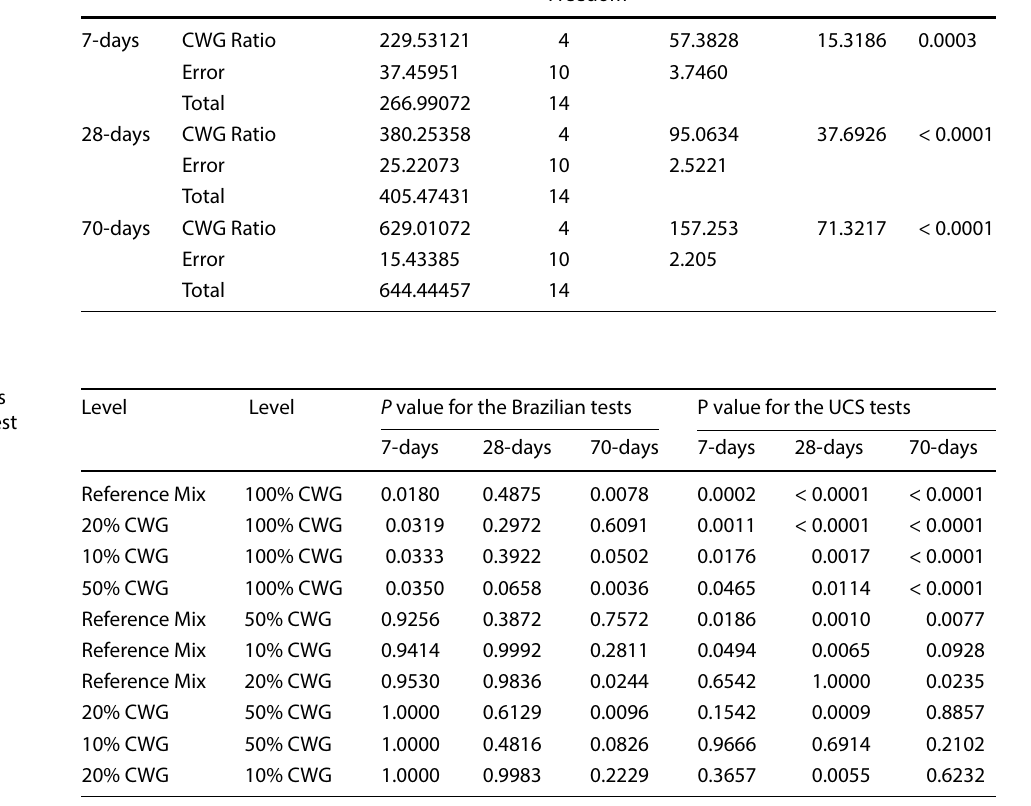
Table 7 ANOVA Test Results for the UCS tests